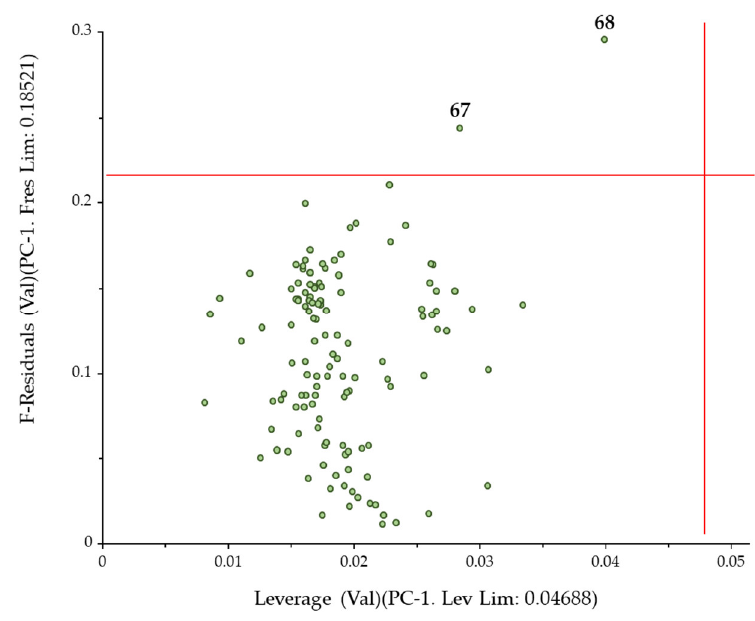
Figure 3. F-Residuals vs.